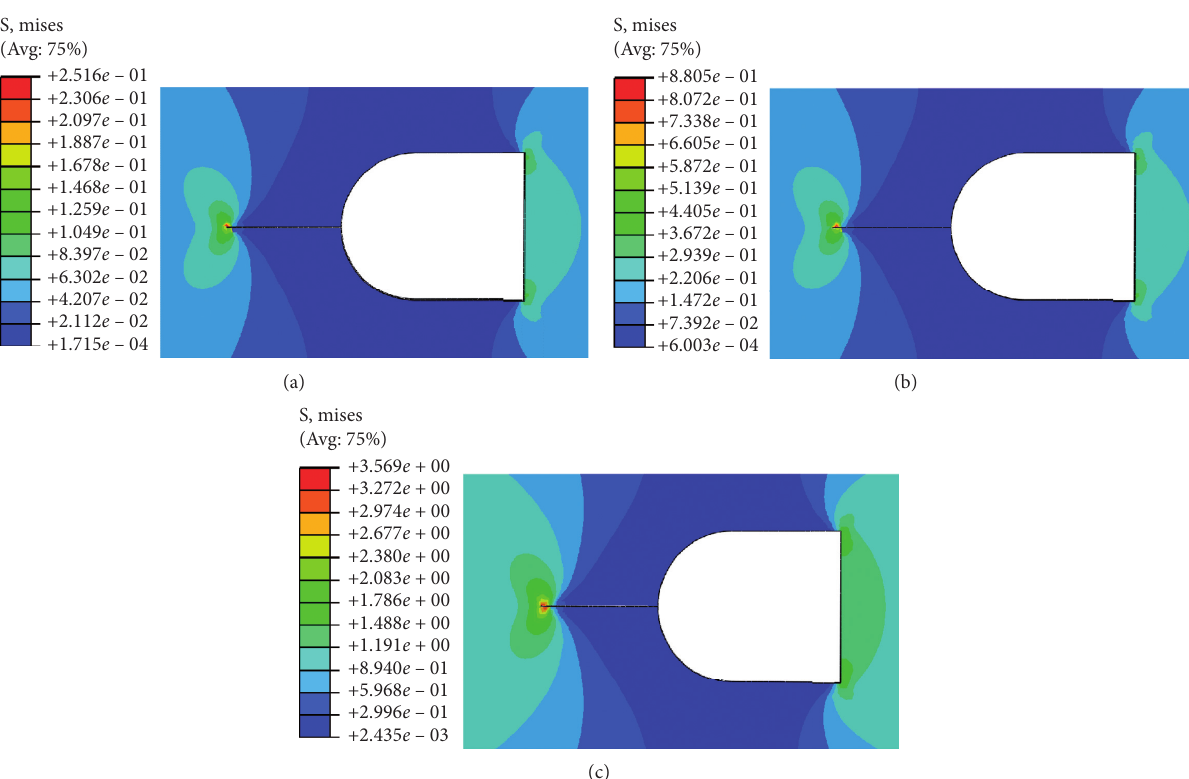
Figure 18: Stress contours of the crack tip at different times in the energy accumulation stage. (a) 50.53 µ s. (b) 175.69 µ s. (c) 326.46 µ